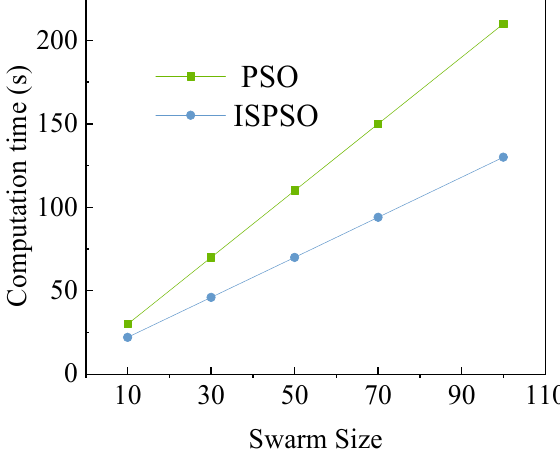
Figure 4. Computation time as a function of swarm size under different algorithms. The mean radius ( r m ) and standard deviation ( σ ) of the ISPSO algorithm and the PSO algorithm for 50-times calculation are shown in Figure 5 (the upper limit of the number of iterations is 500). The inversion results of the ISPSO algorithm are completely concentrated in the neighborhood range of ( r m , σ ) = (1.0, 0.5), so the ISPSO algorithm does not fall into the local optima. However, some of the results of the PSO algorithm fall in another area, which can be considered to fall into the local optima (The distributions of other inversion parameters are shown in Figures A2 and A3).